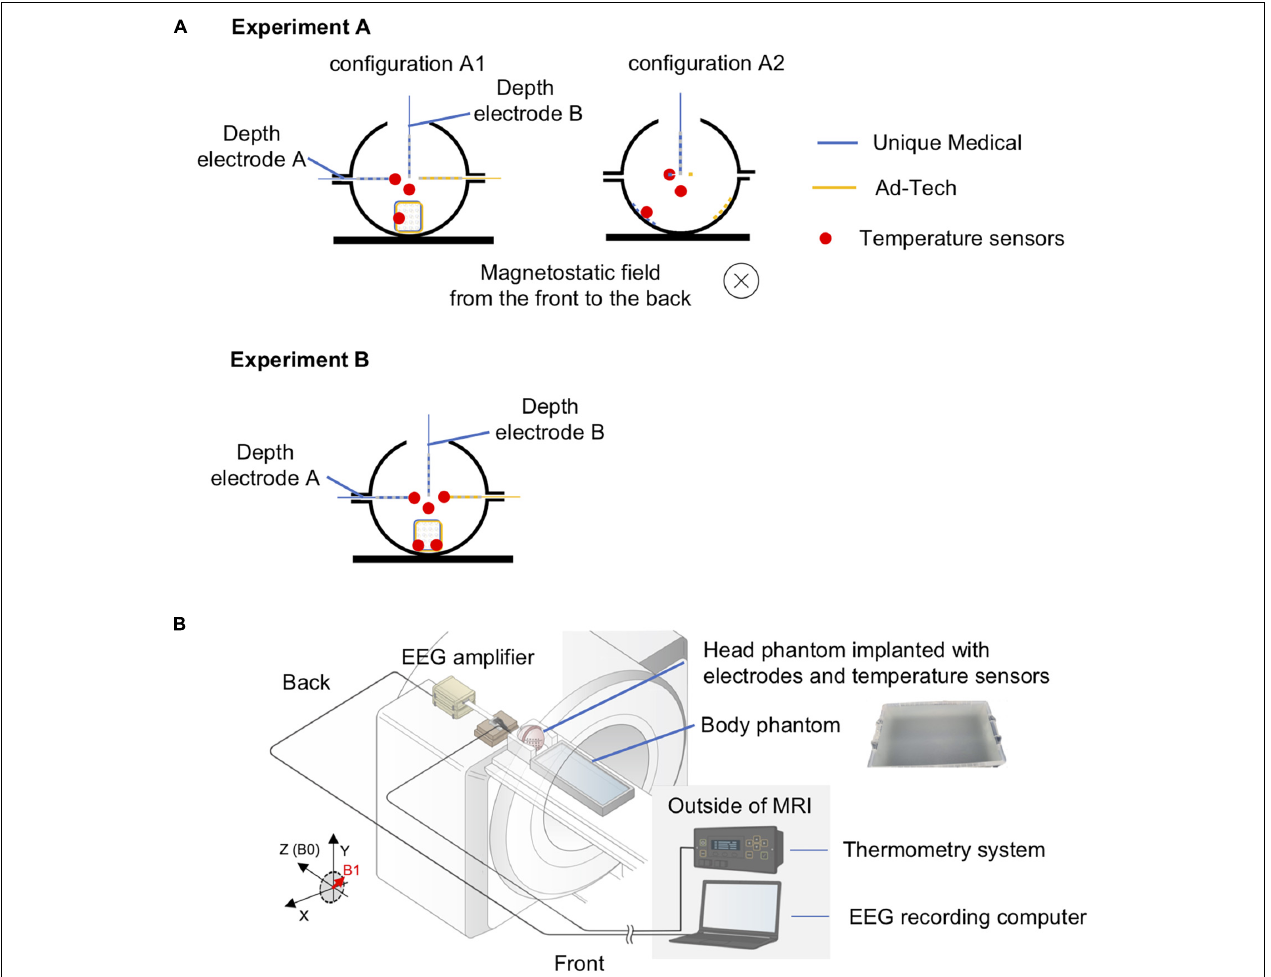
FIGURE 2 | Experimental setup for temperature measurement of radiofrequency-induced heating. (A) Orientation of the head phantom and the location of temperature sensors during experiment A (upper panel) and experiment B (lower panel). In experiment A, two conditions were tested: configuration A1 – electrodes placed orthogonal to the direction of the static magnetic field; configuration A2 – electrodes placed parallel to the direction of the static magnetic field. The blue electrodes were Unique Medical electrodes, and the yellow electrodes were Ad-Tech. The location of a temperature sensor was indicated as red dot. The red dot distanced from all electrodes represents the sensor placed within the gel to serve as control. Experiment B was performed twice: two sensors were placed on Unique Medical electrodes during the first and on Ad-Tech electrodes during the second time. (B) Layout of the phantoms and all of the equipment during experiments for temperature measurement. The head and body phantoms were placed in the magnetic resonance imaging (MRI) scanner with the head at the isocenter to emulate an actual simultaneous acquisition of icEEG and fMRI (icEEG-fMRI). The electrodes implanted in the head phantom were connected to the EEG amplifier placed at the “back” of the MRI bore, with exactly the same configuration as an actual icEEG-fMRI acquisition in human subject. The electrodes were secured using memory foam cushions in the head coil and cables were secured using sandbags to prevent movements resulted from mechanical vibration of the MRI scanners during the experiment. The fiber optic MRI-compatible temperature sensors, fixed to the intracranial electrodes, were connected via optical fibers to the thermometry system placed outside the MRI in the control room.